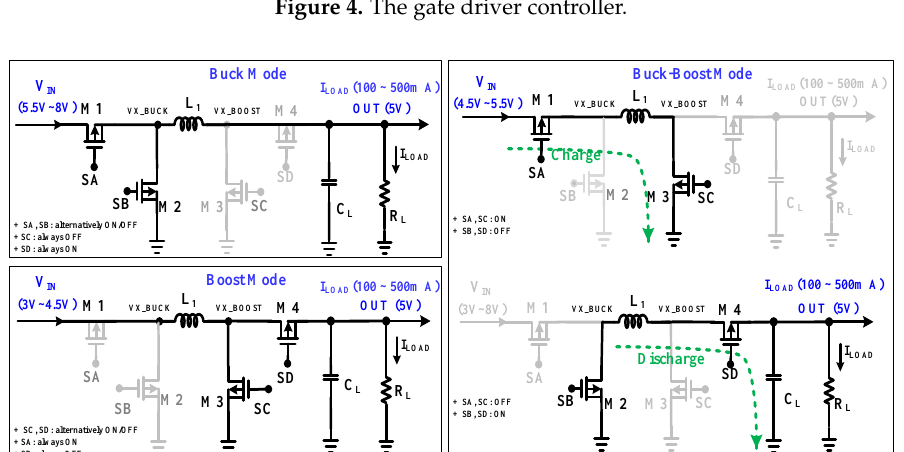
Figure 4. The gate driver controller.